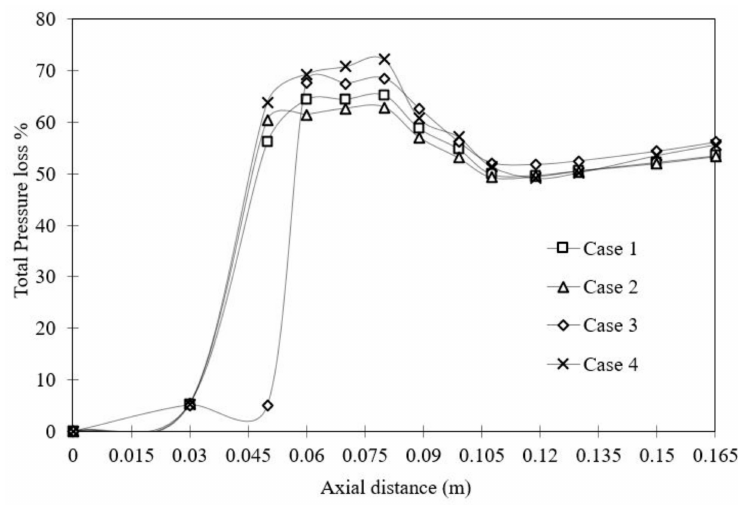
Figure 12. Total pressure loss across the